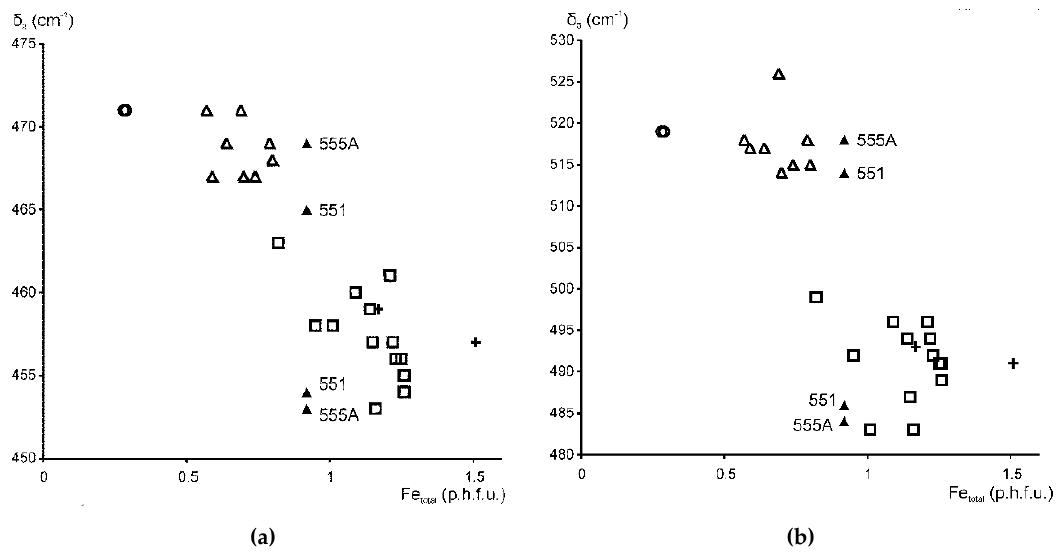
Figure 5. Band positions (cm − 1 ) of ( a ) δ 2 and ( b ) δ 3 in Fe-bearing K-dioctahedral 1 M micas plotted vs. Fe total contents (cations p.h.f.u. ). Symbols: open circles—Fe-bearing Mg-rich illites ( K Al = 0.9), open triangles—Fe-illites and Al-glauconites ( K Al = 0.6–0.75), black triangles—Al-glauconites ( K Al = 0.5), open squares—glauconites ( K Al < 0.5), crosses—celadonites ( K Al < 0.15).